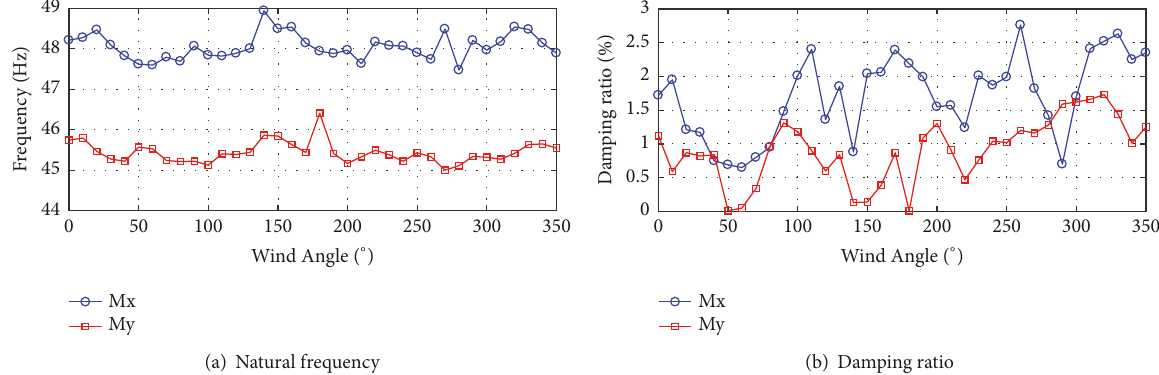
Figure 6: Simulated wind field: (a) mean wind speed profile and (b) turbulence intensity profile.